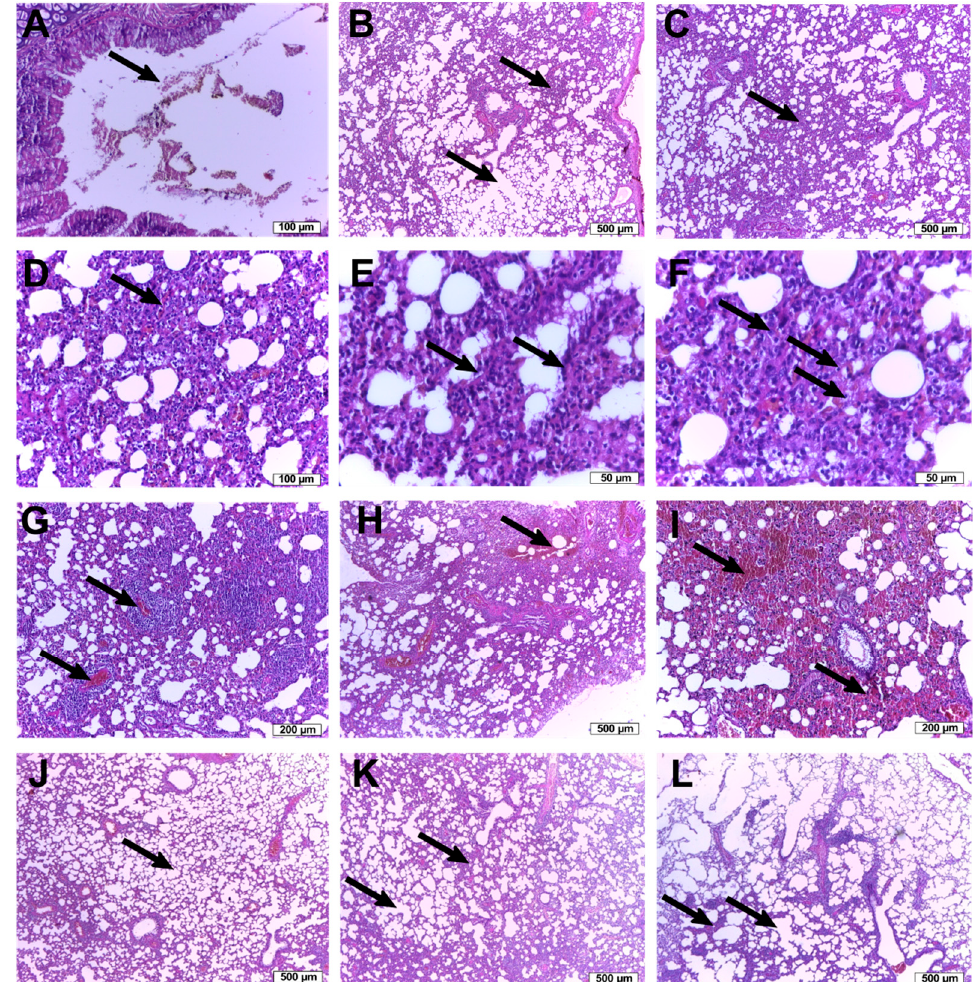
Figure 5. Lung tissue histopathological analysis: Negative control group ( A – I ): ( A ) serohemor- rhagic bronchial intraluminal exudate; ( B ) collapsed alveolar septa and the emphysematous alveo- li; ( C ) thickened alveolar septa; ( D ) hyperhemic alveolar capillaries with septal hypercellularity; ( E ) unflattened cubic pneumocytes; ( F ) septal macrophages and inflammatory cells; ( G ) lymphocytic infiltrate; ( H ) extensive intra-alveolar hemorrhage; ( I ) intra-alveolar red cells (hemorrhage); WSE group: ( J ) normal appearance of the respiratory parenchyma; WSE 1:2 group: ( L ) the thickened alveolar septa and emphysematous alveoli; Codeine group: ( K ) the thickened alveolar septa and emphysematous alveoli .